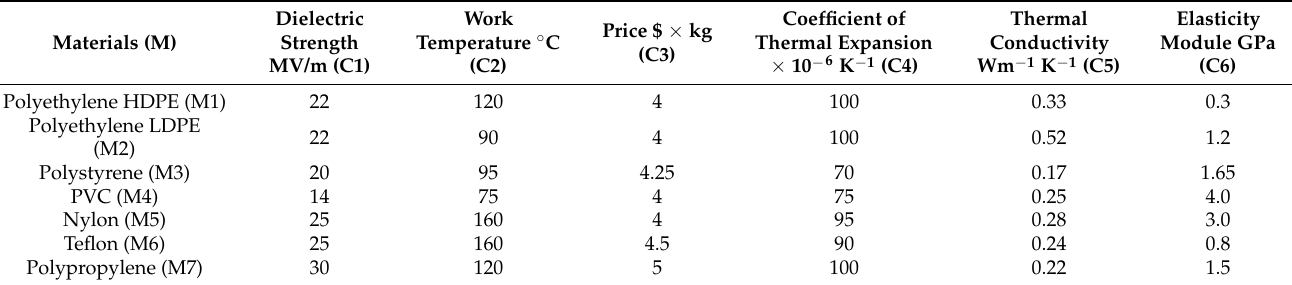
Table 7. Data to form the VIKOR decision matrix.